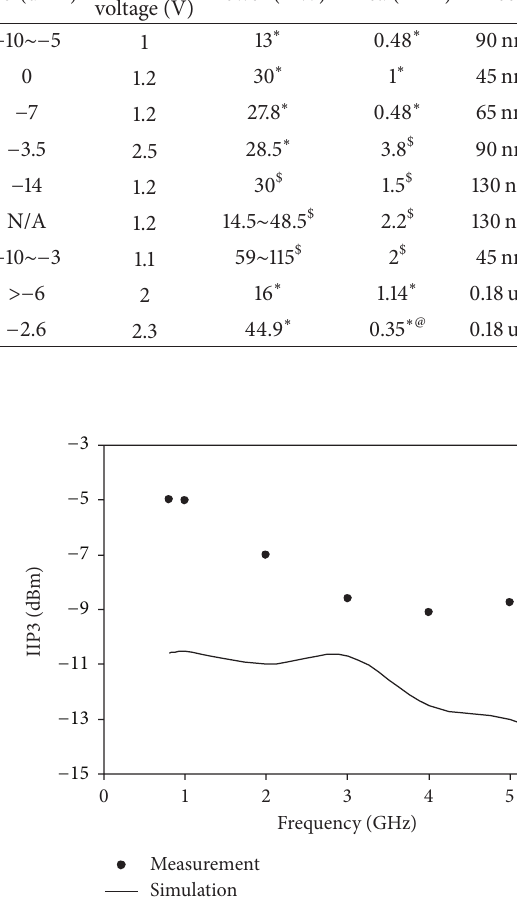
Figure 7: Noise figure of the proposed receiver front-end.